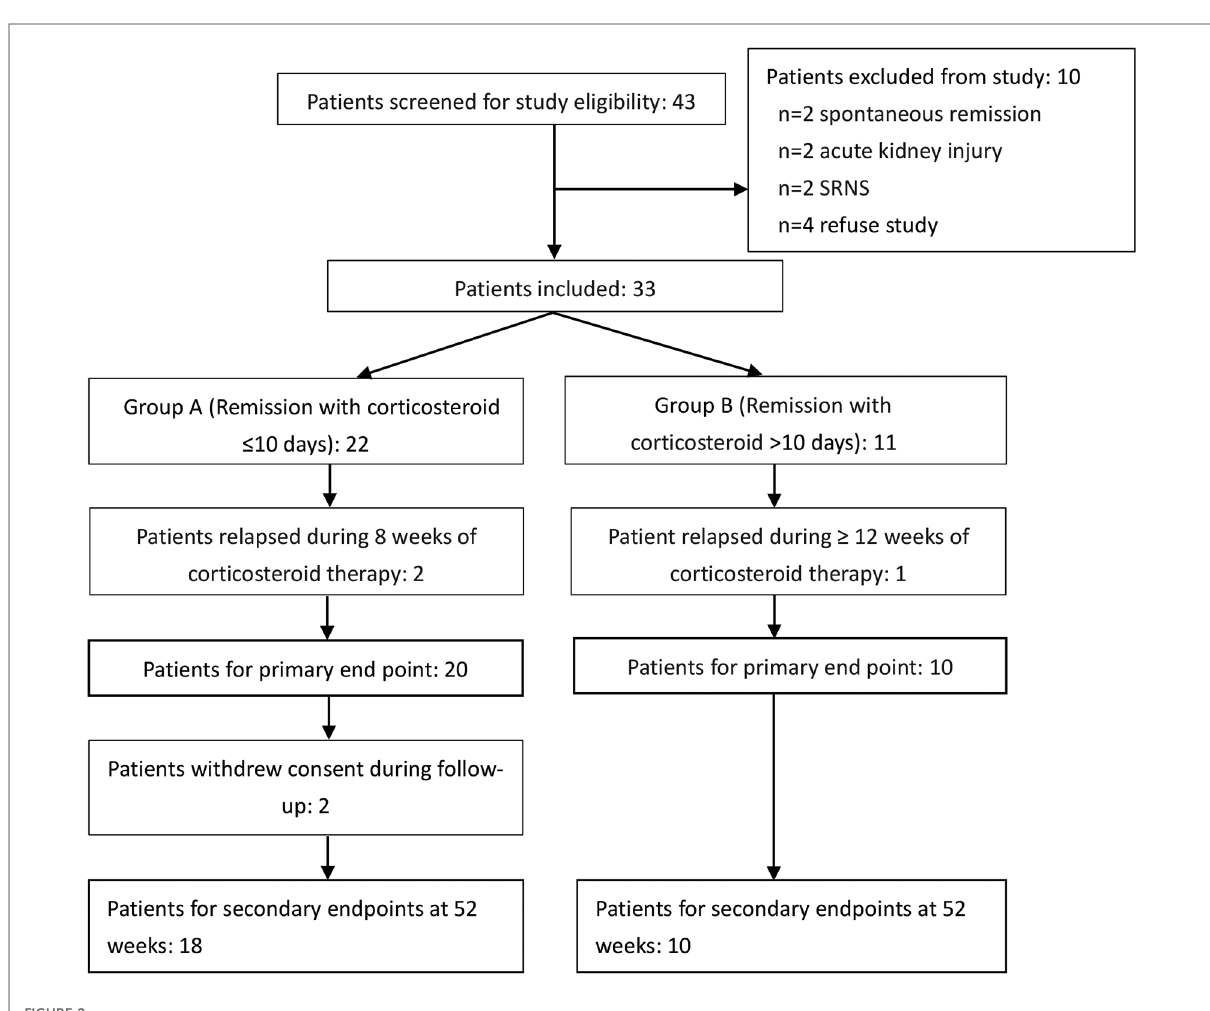
FIGURE 2 Flow diagram of patients included in the